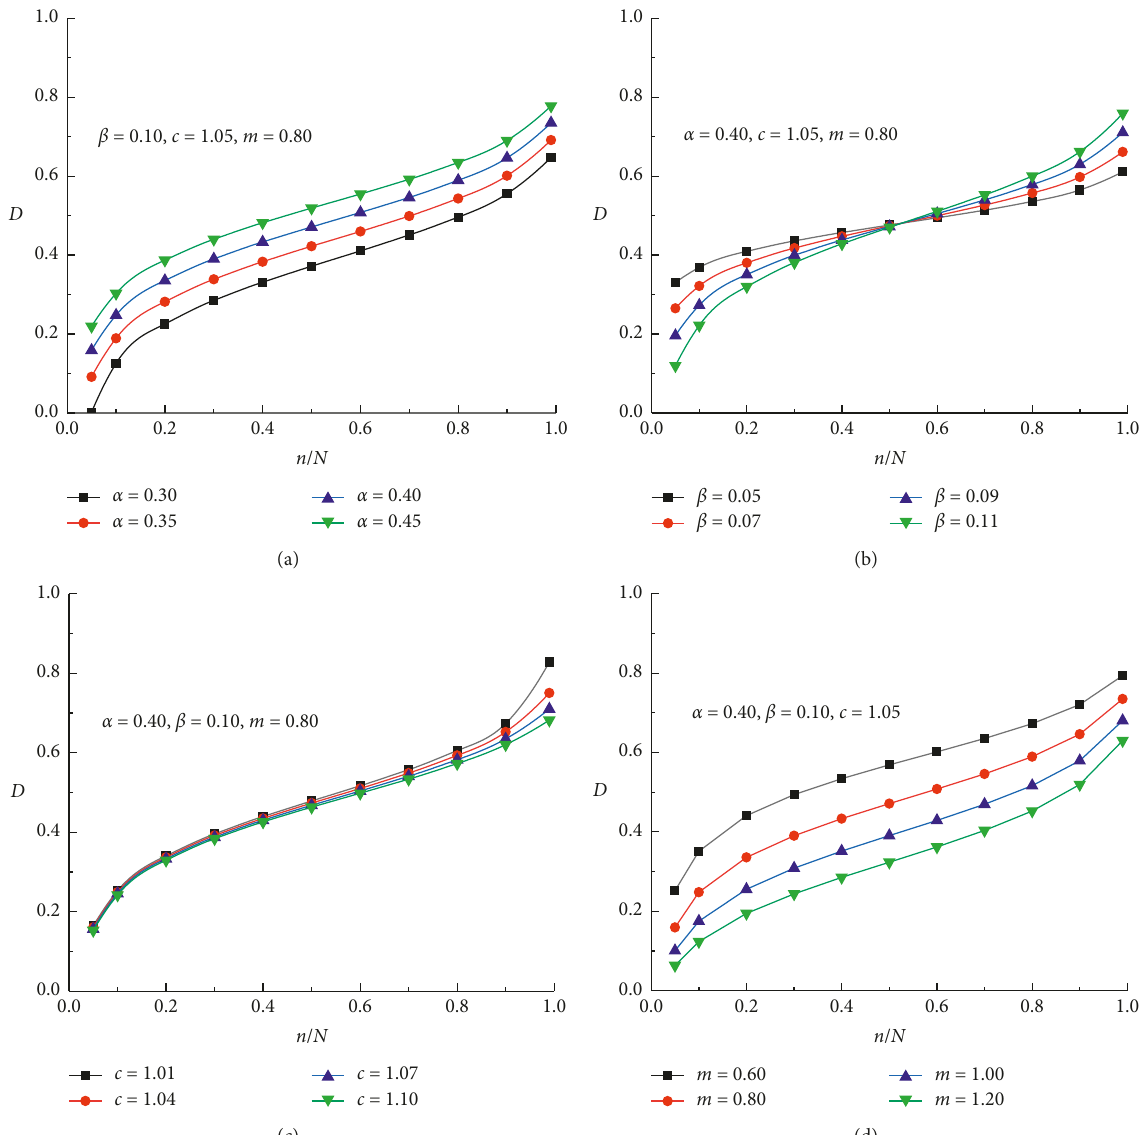
Figure 11: Influence of parameter (a) α , (b) β , (c) c, and (d) m on damage model